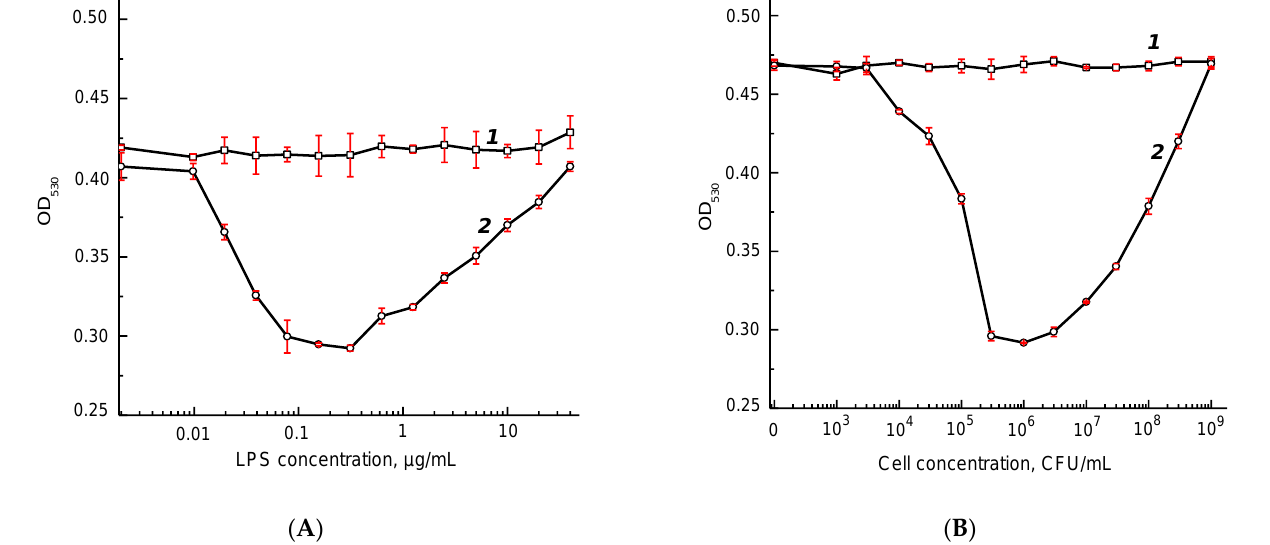
Figure 6. Calibration curves for AuNPs2 – T143 agglutination at 530 nm in the presence of different concentrations of F. tularensis LPS ( A ) and F. tularensis subsp. holarctica 15 NIIEG ( B ). Curves 1 and 2 correspond to 1 and 20 min of the reaction. Measurements were made in triplicate.